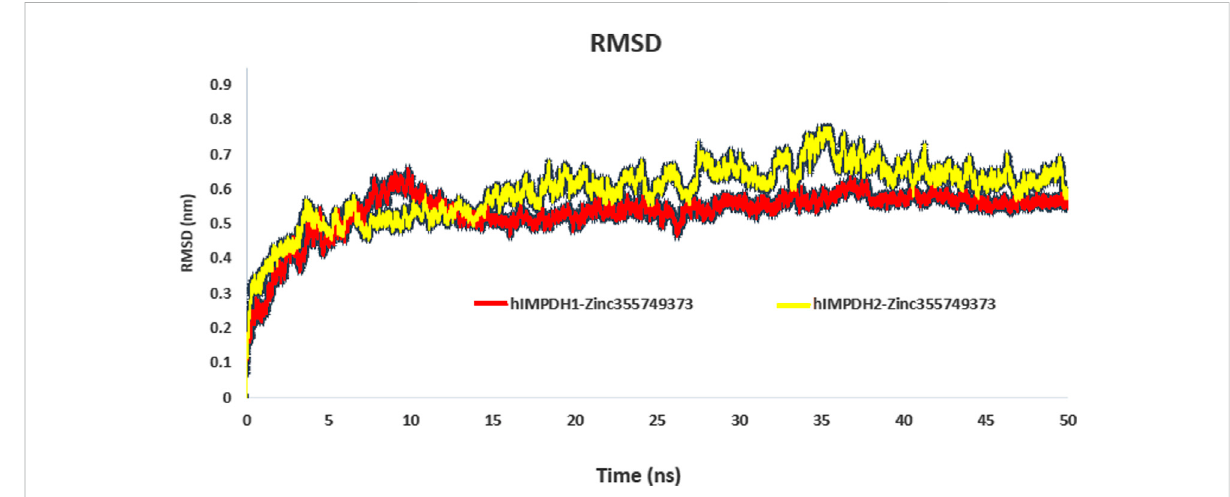
FIGURE 3 RMSD plot of hIMPDH isoforms (monomeric forms) in complex with selected ligand during the course of 50 ns simulation